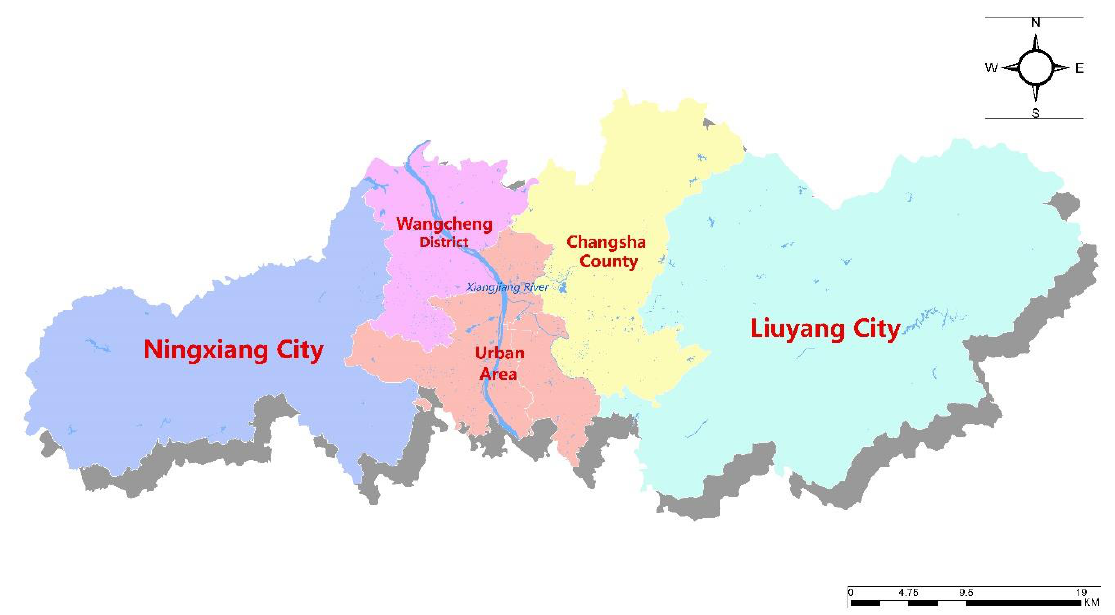
Figure 3. The administrative division map of Changsha city.